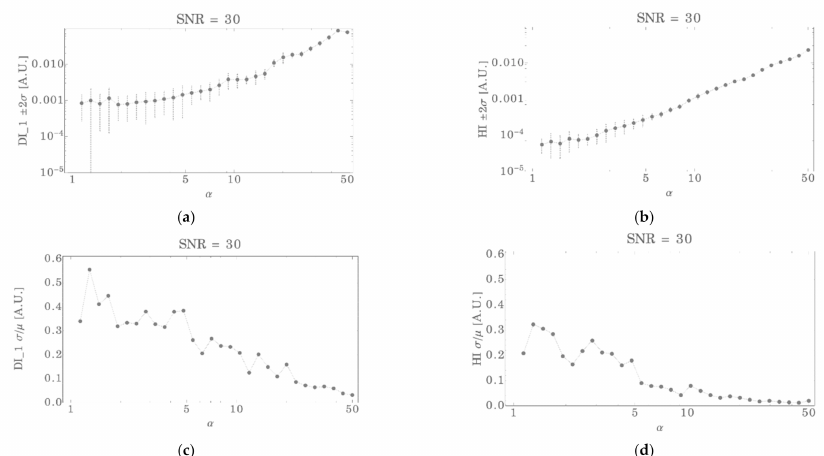
Figure 5. Mean value and standard deviation ( ± 2 σ ) of the estimators depending on the amount of damage α . ( a ) Double logarithmic scale representation of damage indicator DI 1 @ SNR = 30 dB; ( b ) double logarithmic scale representation of the proposed damage indicator HI @ SNR = 30 dB; (cid:16) (cid:17) σ ( c ) for DI 1 @ SNR = 30 dB; ( d ) µ